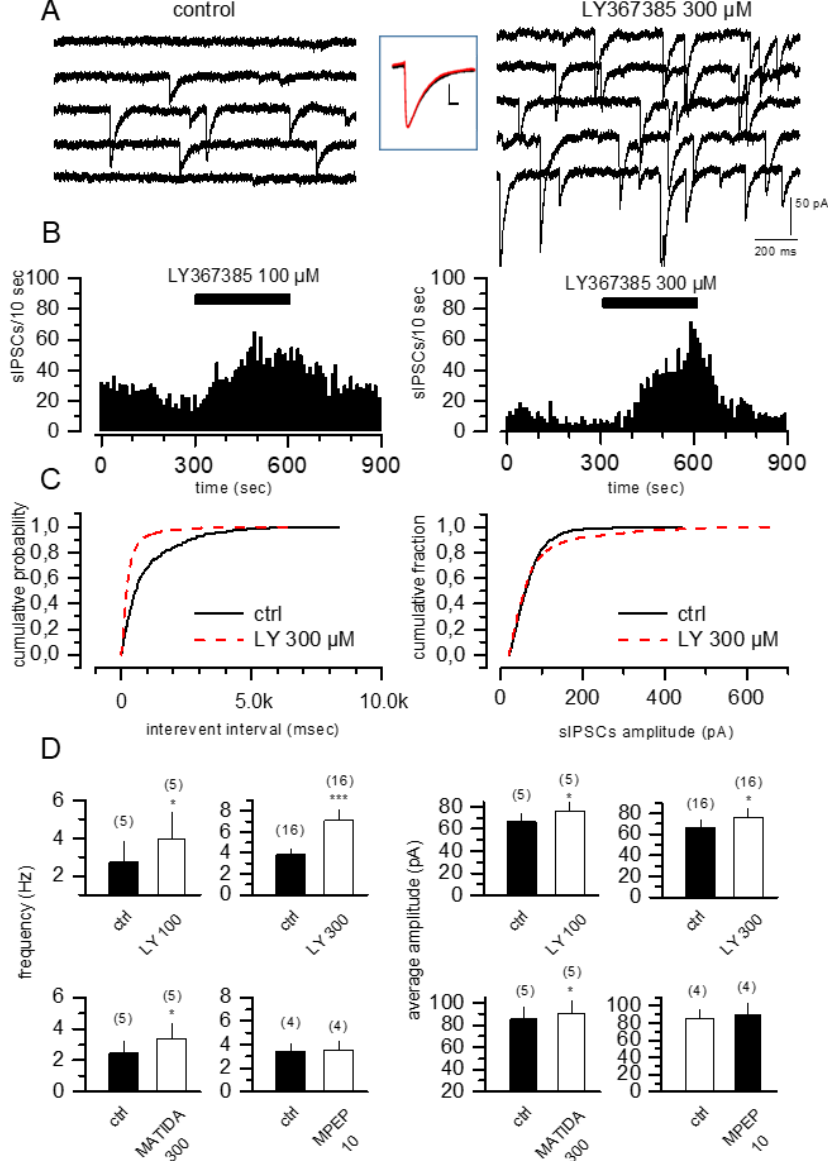
Figure 1. mGlu1 but not mGlu5 receptor antagonists selectively increase the frequency and the amplitude of sIPSCs in CA1 pyramidal cells. ( A ) sIPSCs recorded from CA1 pyramidal single cells before and during LY367385 (300 µM) application. The inset shows superimposed traces of averaged sIPSCs recorded from CA1 pyramidal cell (control, black line: n = 420 events; LY367385, red line: n = 1400 events). Scale bar in inset 10 ms and 100 pA. ( B ) Frequency time courses recorded from single cells showing the reversible increase in sIPSCs frequency mediated by application of 100 µM (left) and 300 µM (right) LY367685. ( C ) Cumulative probability plots demonstrating the effect of LY367385 on sIPSCs interevent interval and amplitude [Kolmogorov–Smirnov test; p < 0.001]. ( D ) Bar graphs showing the increase in frequency and amplitude of sIPSCs induced by different concentrations of LY367385 (100 and 300 µM), 3-MATIDA (300 µM) and MPEP (10 µM). The number of cells tested is in parenthesis; values are the means ± SEM. * p < 0.05, *** p < 0.001 versus control, Student’s t test.